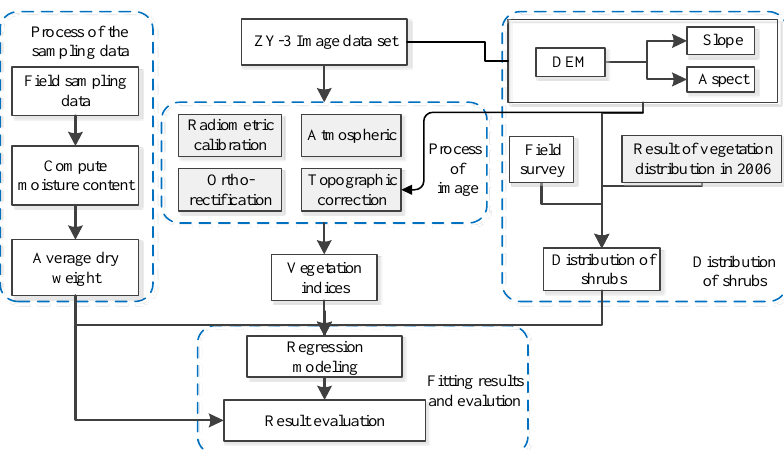
Figure 4. Processing flowcharts of biomass